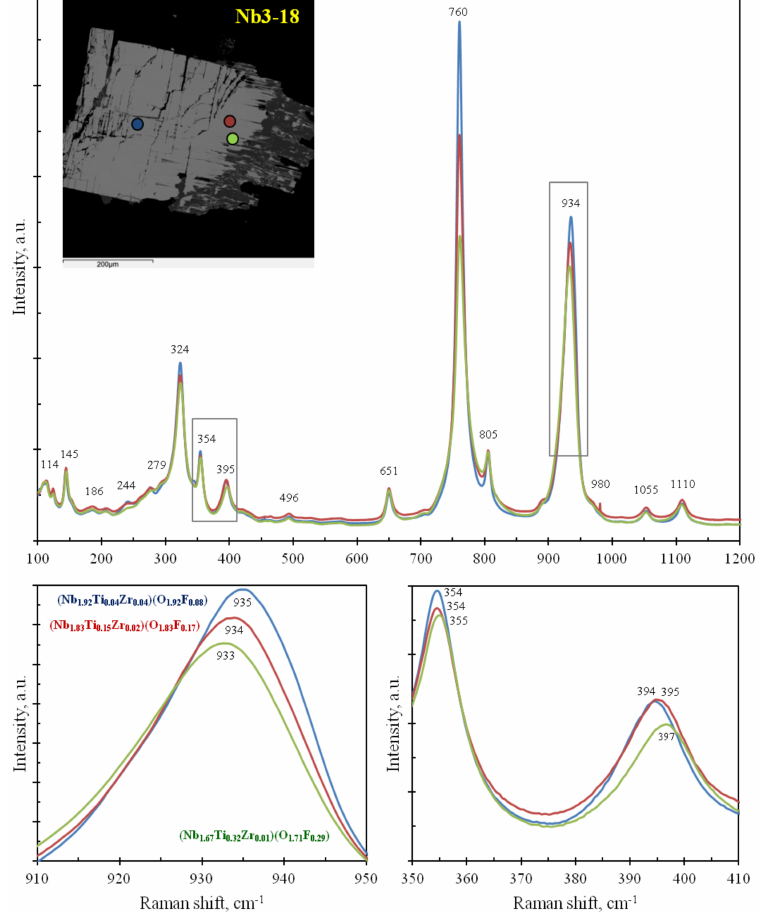
Figure 13. Raman spectra for a zoned rippite crystal showing dependence of some bands on chemical composition. For some details see Figures 5 and 8 and Table 2 and Table